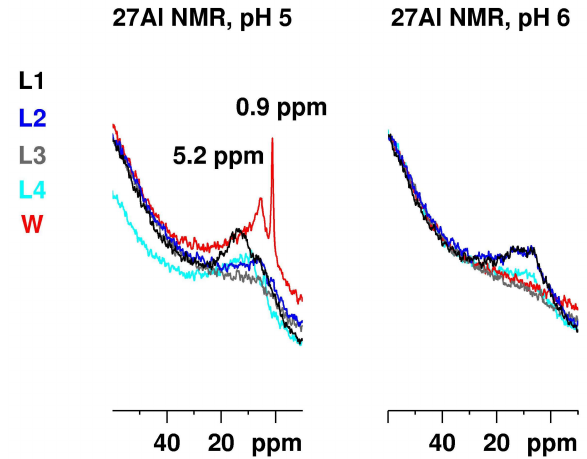
Figure 5. 27 Al NMR of Al 2 (SO 4 ) 3 with a concentration of 50.0 g/L at pH 5 ( left ) and 6 ( right ) recorded at the same conditions for the different media L1–4 and water. The signals at − 2.4 ppm for the [Al(H 2 O) 5 SO 4 ] + are no longer visible for all media. The signal at 0.9 ppm for the aluminium hexahydrate is detected only in the case of the water solution.The resonance at 5.2 ppm for the dimer is observed clearly in the water solution and significantly reduced in L1 medium. A new broadened 27 Al resonance at ca. 12 ppm appears instead. At pH 6, this broad signal remains only in the RPMI and DMEM